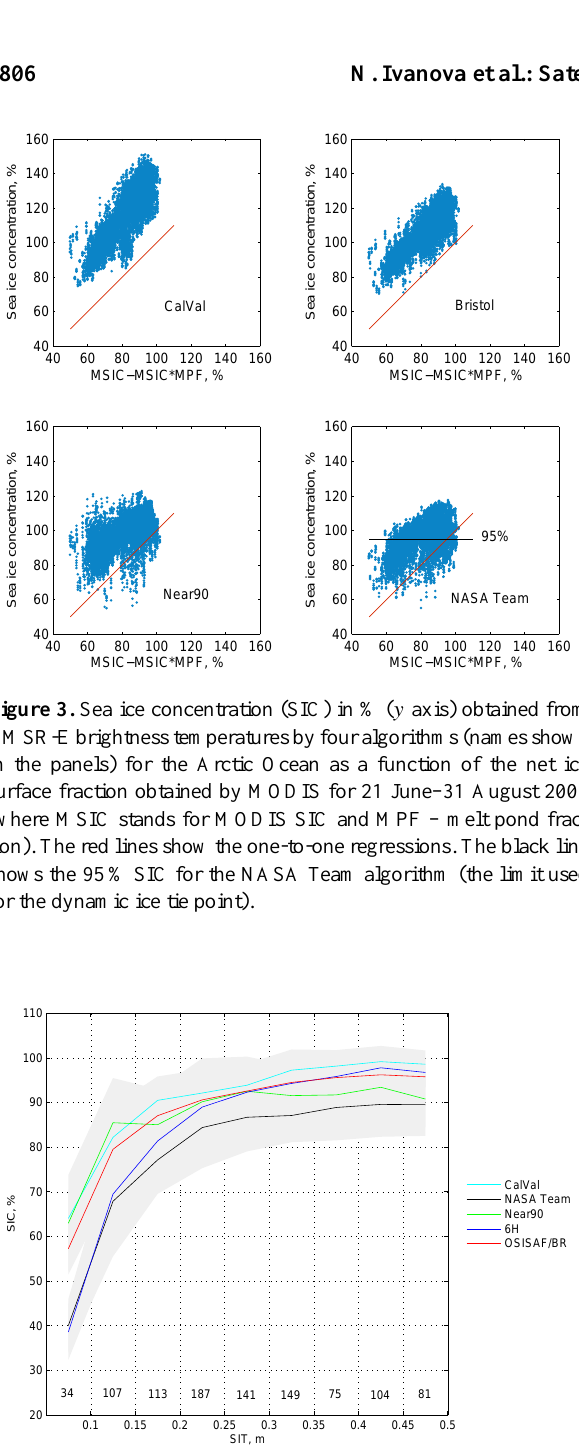
Figure 4. Sea ice concentration (SIC) calculated by the SIC algo- rithms (shown in colours) as a function of SMOS sea ice thickness (SIT) in areas of the Arctic Ocean, which are known to be ∼ 100% thin ice during the time period from 1 October to 12 December 2010. Grey shading shows standard deviations of the algorithms. Number of measurements in each bin is shown above the x axis (total number is 991). In this SIC range OSISAF is the same as